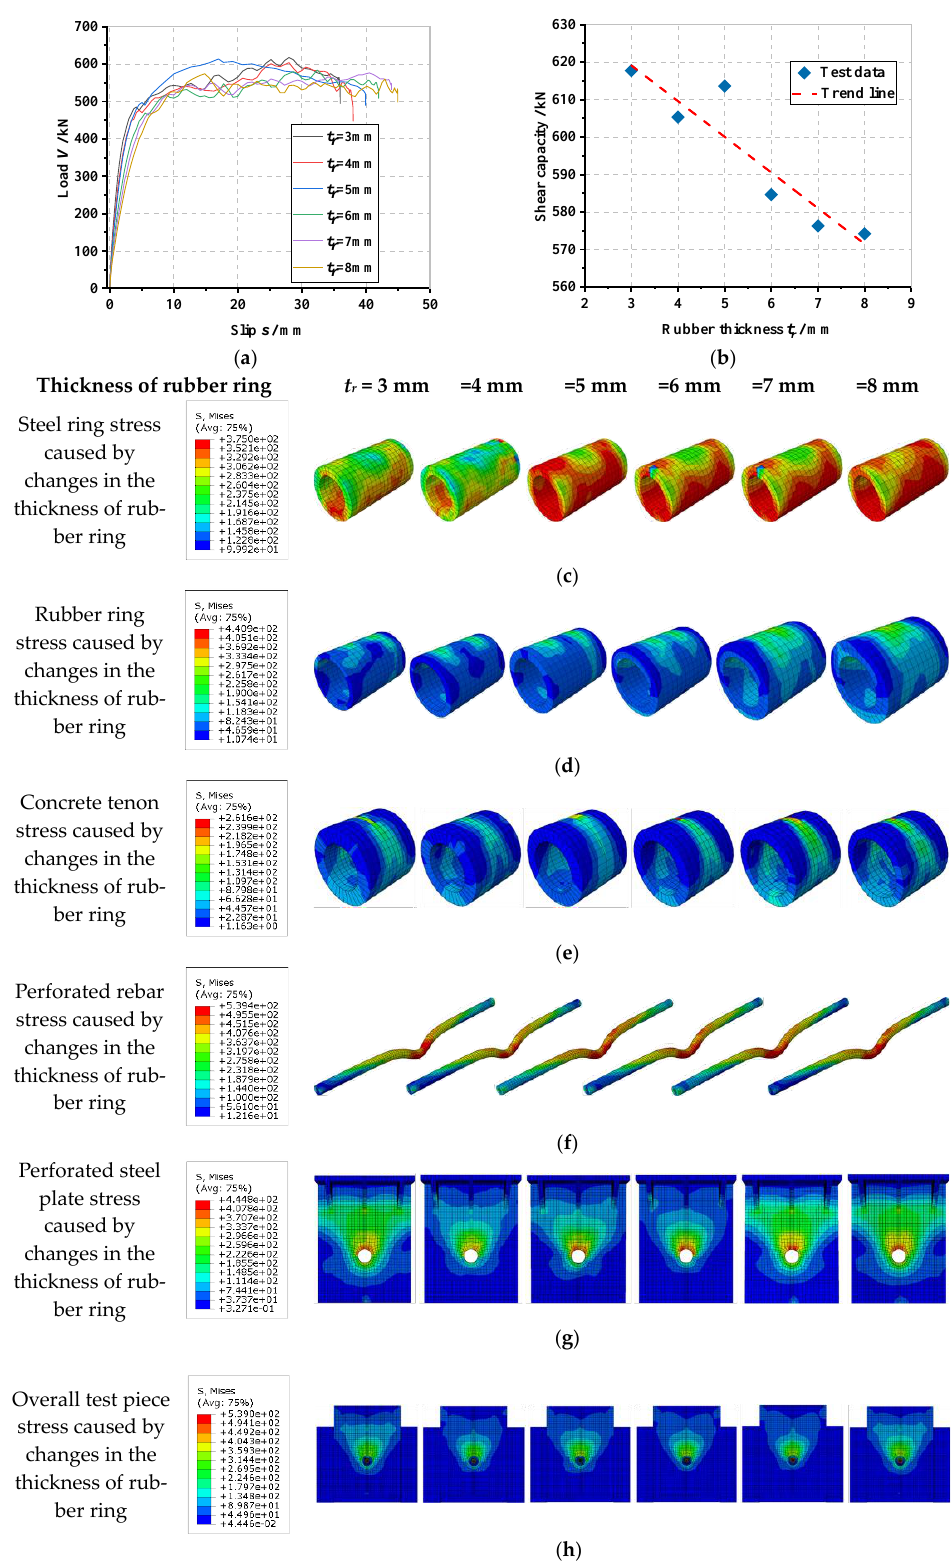
Figure 11. Influence of rubber ring thickness: ( a ) overall load – slip curves, ( b ) impact analysis, ( c ) steel ring stress, ( d ) rubber ring stress, ( e ) concrete tenon stress, ( f ) perforated rebar stress, ( g ) perforated steel plate stress, ( h ) overall stress in the specimen.